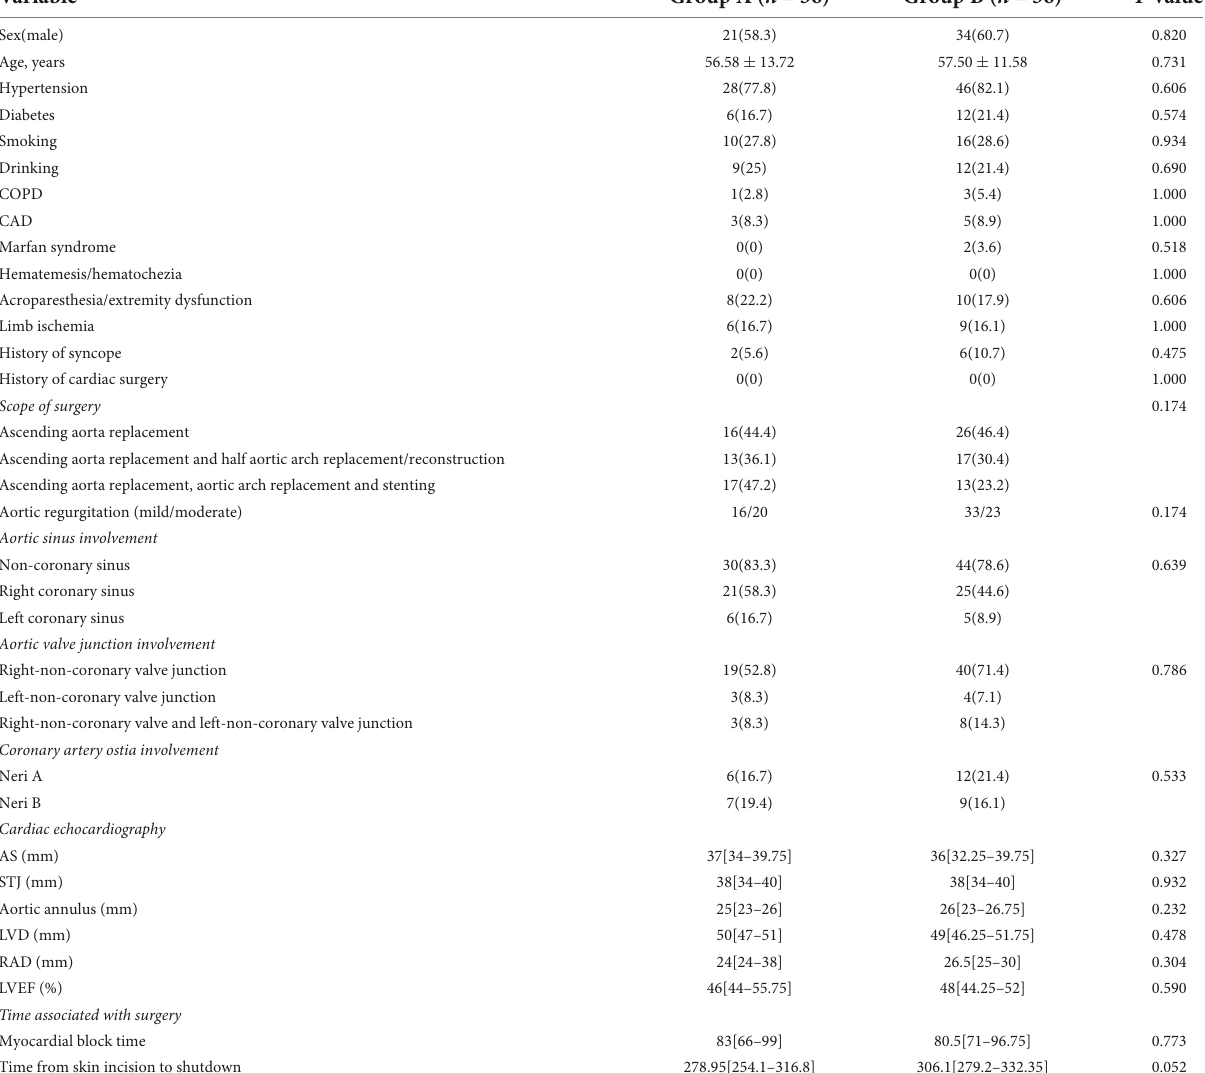
TABLE 1 Baseline